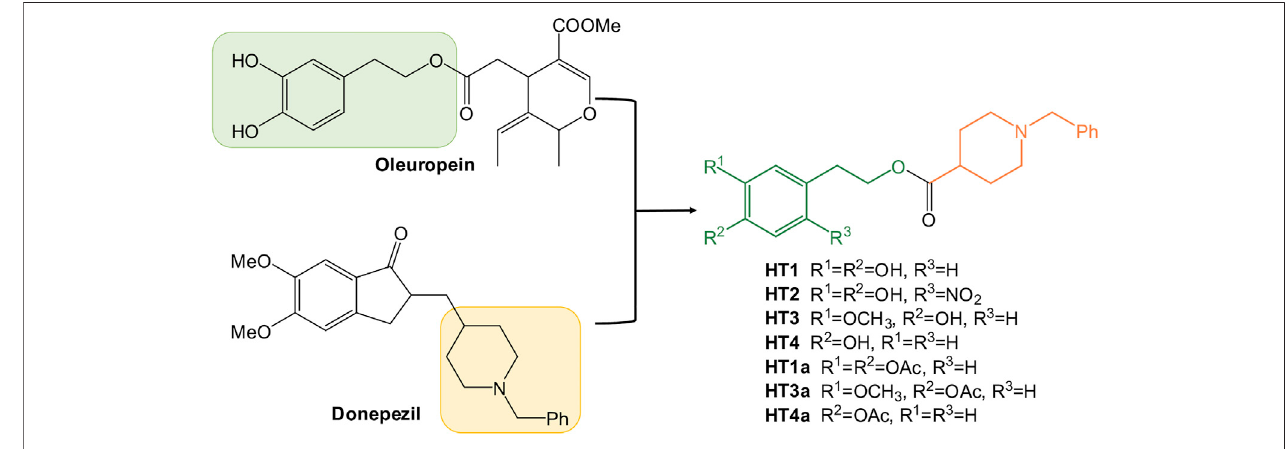
FIGURE 1 | Development of new hydroxytyrosol-donepezil